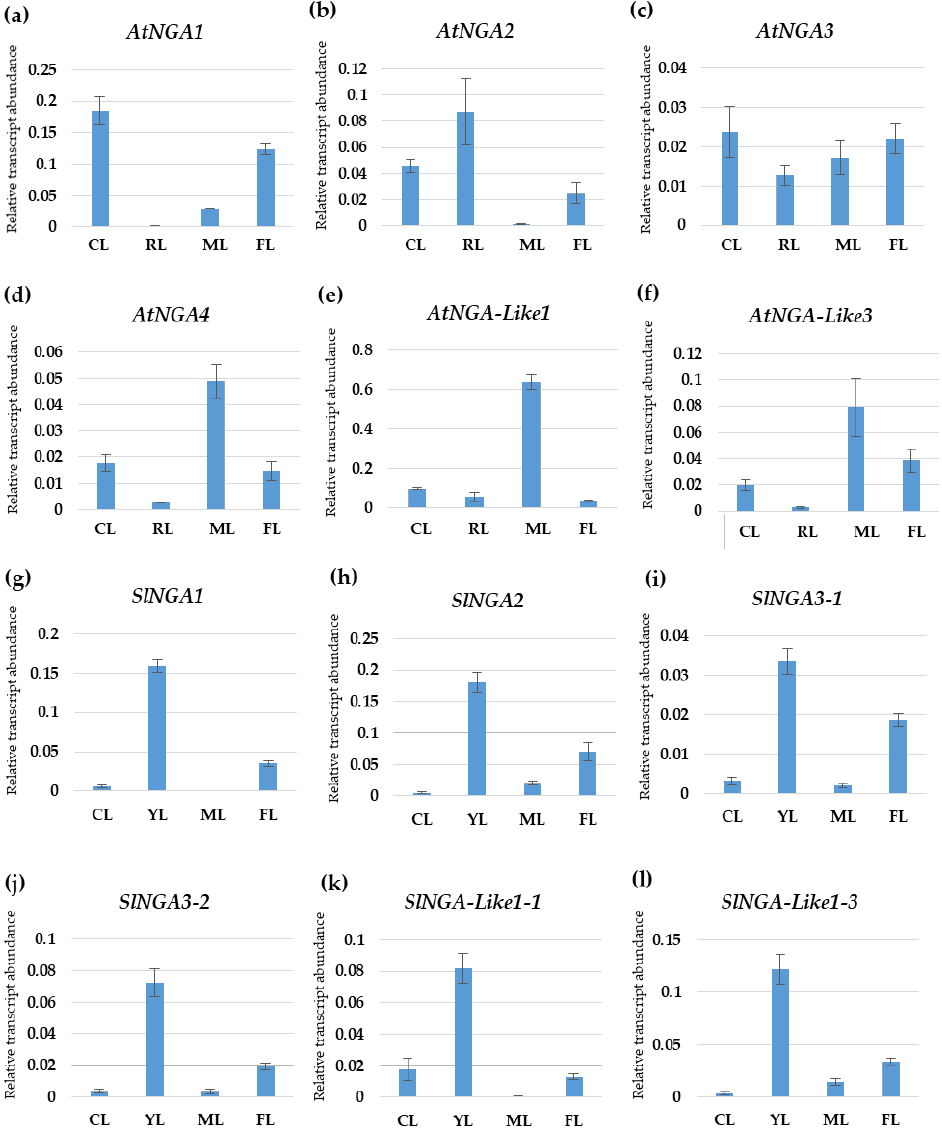
Figure 7. The expression patterns of the NGATHA genes in Arabidopsis ( a – f ) and tomato ( g – l ) in different plant organs were verified by qPCR. The X-axis represents different plant organs: CL—cotyledon, RL—rosetta leaf, FL—flower, YL—young leaf, ML—mature leaf. The Y-axis represents the relative transcript abundance of the respective genes.